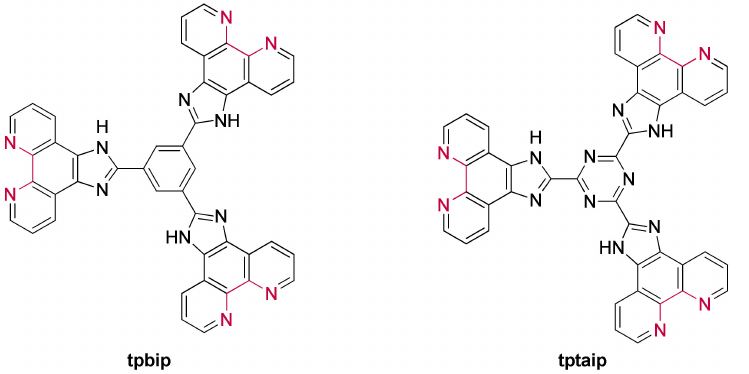
Figure 29. Structure of two bridging imidazo-phenanthroline ligands used to form trinuclear ruthe- nium(II) complexes studied for their interaction with G-quadruplexes.